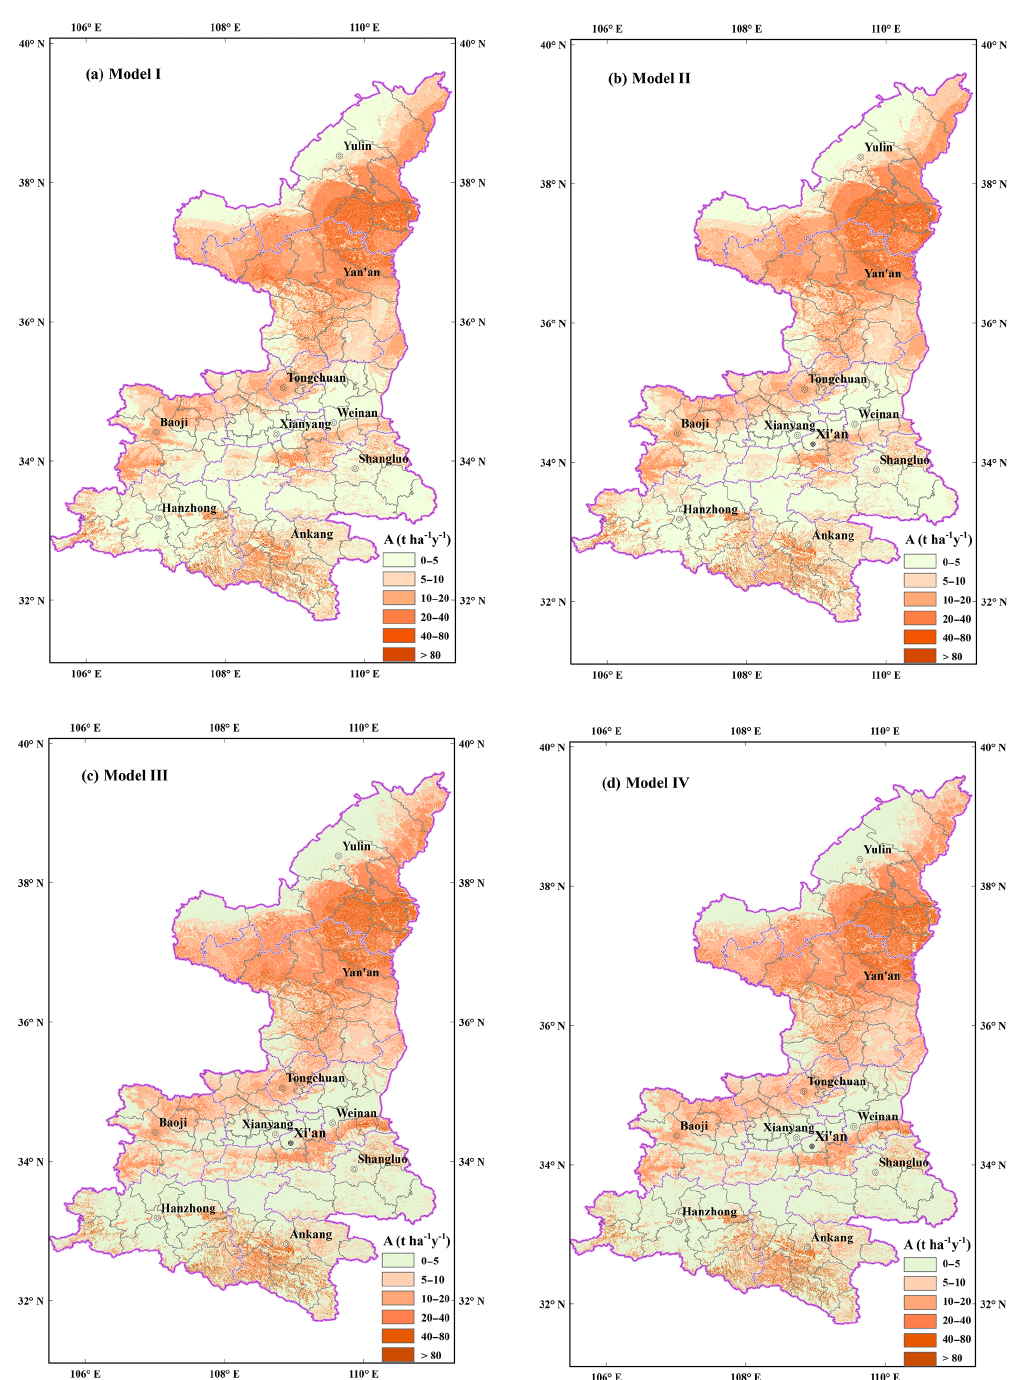
Figure 10. Distribution of soil erosion intensity levels for four models: (a) Model I, (b) Model II, (c) Model III, and (d) Model